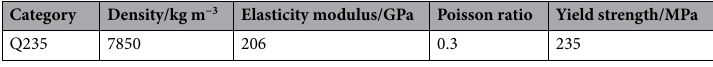
Table 1. Q235 steel parameters.